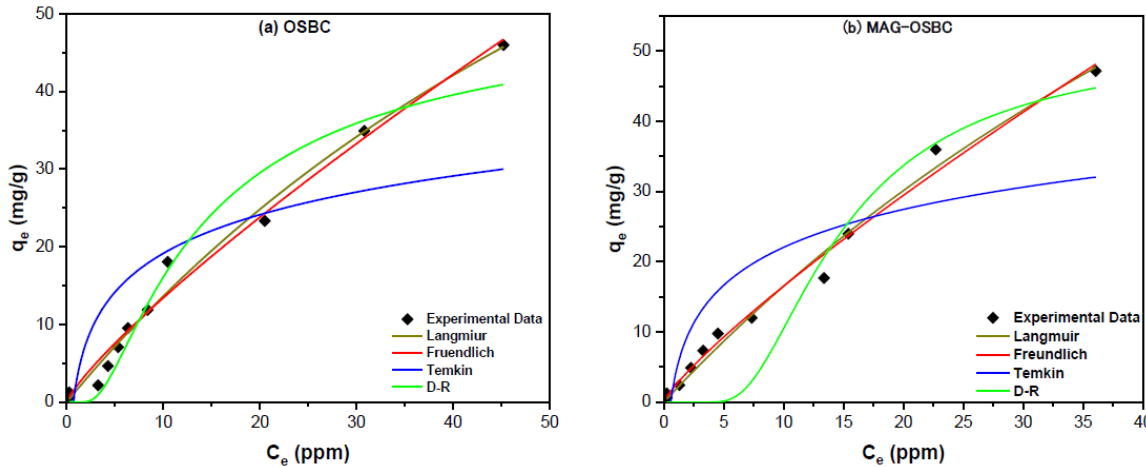
Figure 10. Adsorption isotherms of CLOF onto ( a ) OSBC and ( b ) MAG–OSBC, including Langmuir, Freundlich, Temkin, and Dubinin–Radushkevich (D–R)